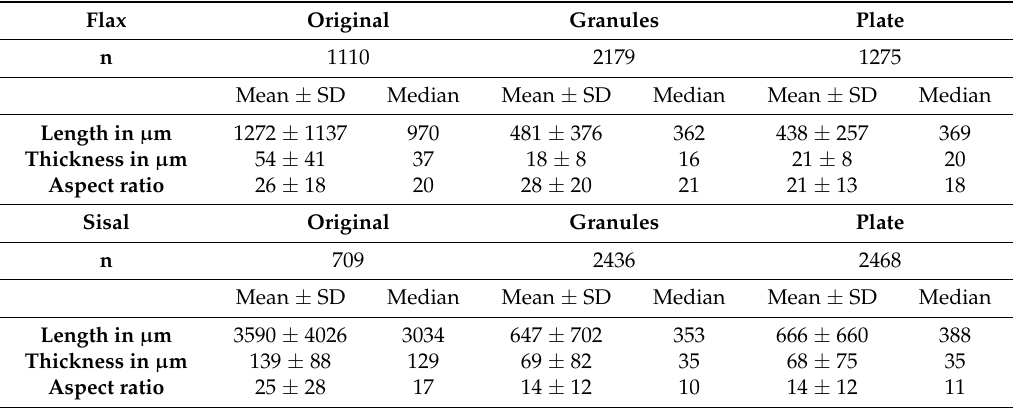
Figure 11. Change of the aspect ratio for sisal ( left ) and flax ( right ): before processing (original), after compounding (granules), and after injection moulding (plate). The results are shown as box-and-whisker plots (whiskers with a maximum of 1.5 × IQR, outliers shown as circles). Boxplots with * represent not normally distributed samples and different capitals represent significant differences. Table 1. Mean, standard deviation (SD), and median of the measured fibre length thickness and aspect ratio for flax and sisal. The analysis was done with FibreShape; n is the number of counted objects. Flax Original Granules